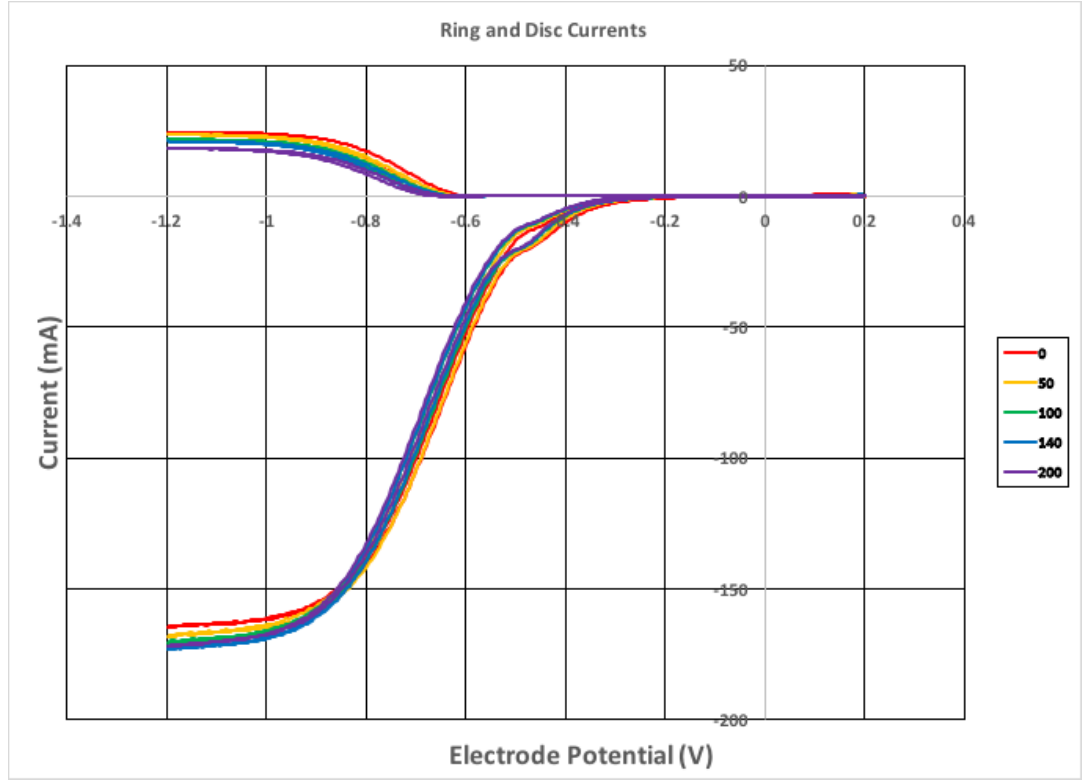
Figure 4. Rotating ring disk electrode (RRDE) voltammograms showing only 5 lines out of 15 for clarity, indicating the volume of aliquots added. The complete set of 15 data is shown in Figure 5.